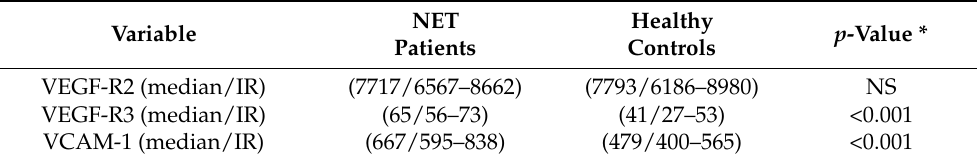
Table 2. Comparison of the studied factors in patients with neuroendocrine tumours (NET) and healthy controls.